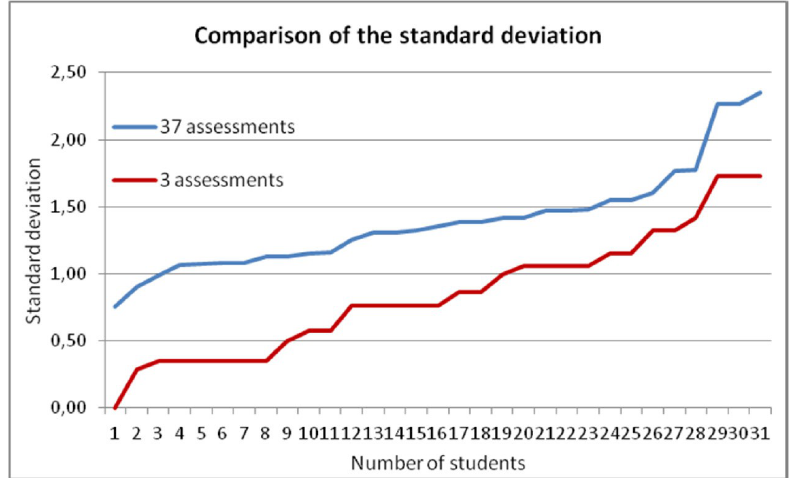
Figure 6. Standard deviaton of the grades given by the students for the both cases considered in the study When the dispersion of the distributons are compared in the case of 3 and the case of 37 peer assessments, the global deviaton tends to increase as the number of peer assessments increases.